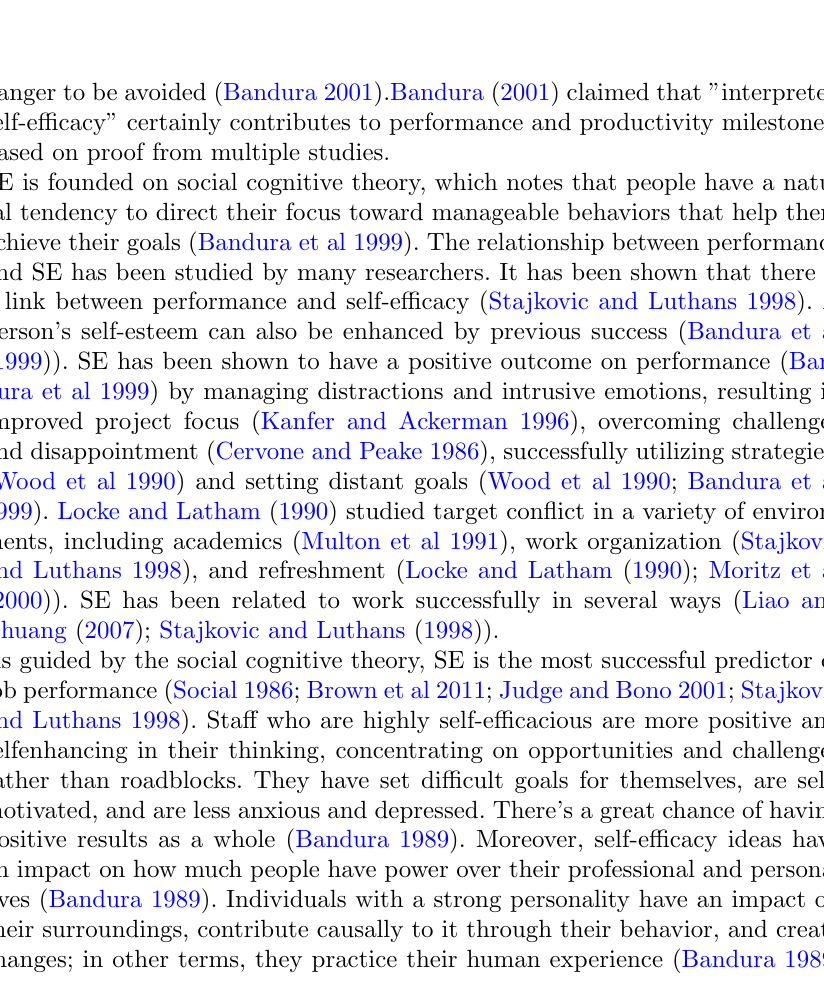
Figure 1: Theoretical Framework Fig. 1: Theoretical